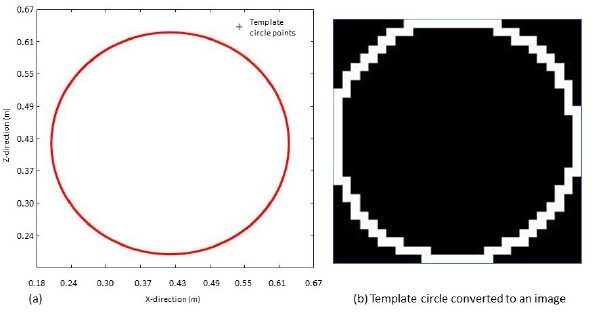
Figure 10. FFT image matching (Smith